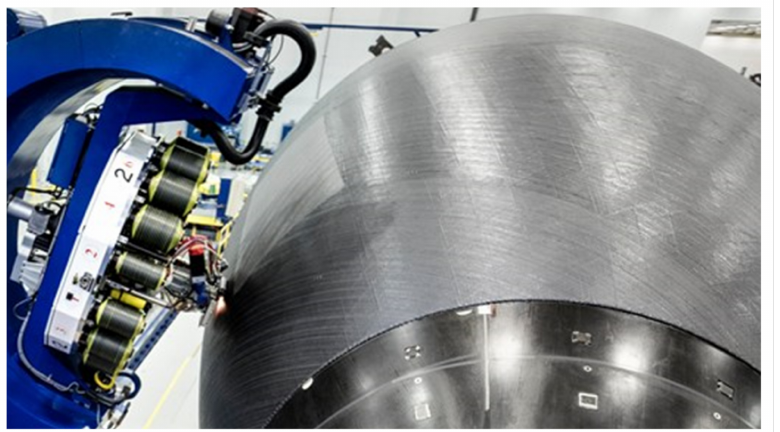
Figure 2. The filament winding manufacturing process for the production of large composite cylindrical structures (Source: Spirit AeroSystems).